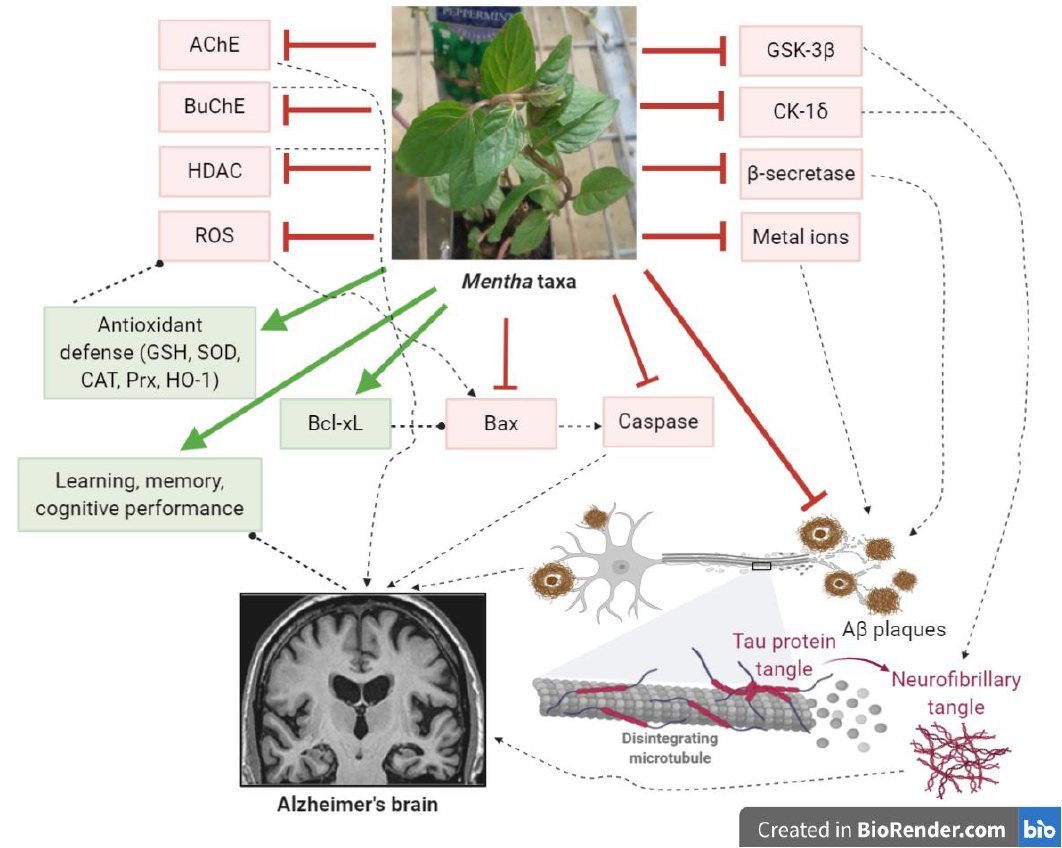
Figure 4. Theoretical scheme of possible mechanisms underlying the neuroprotective effect of Mentha taxa.